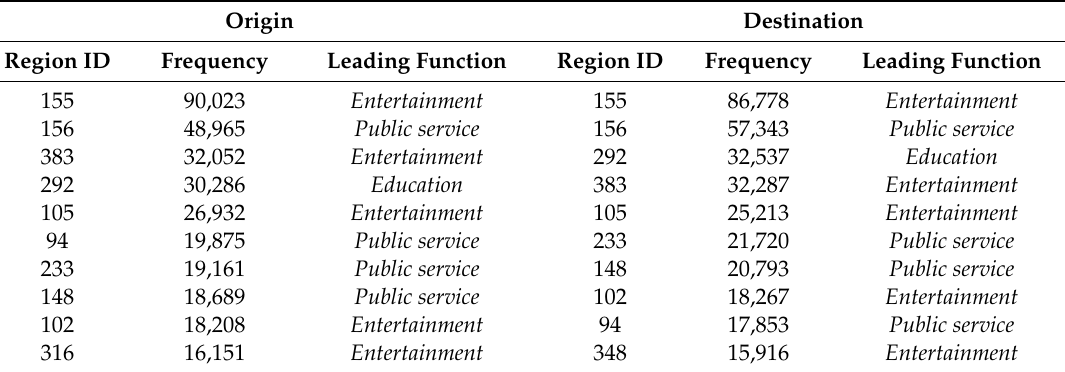
Table 5. Top 10 hot functional